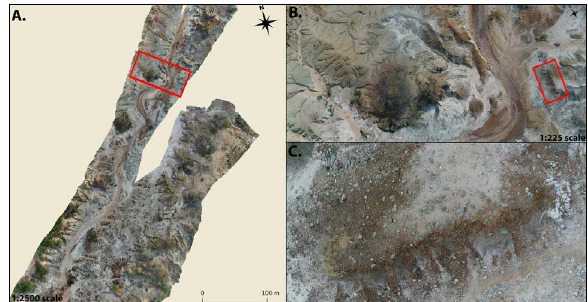
Figure 8: (a) Location within the northern branch of the outcrop with ferrous sediments, outlined in red. (b) Inset of location with ferrous outcrop, outlined in red. (c) Still photo of ferrous sediments with artefacts on the surface taken from the uncrewed aerial vehicle at an altitude of 15 m.